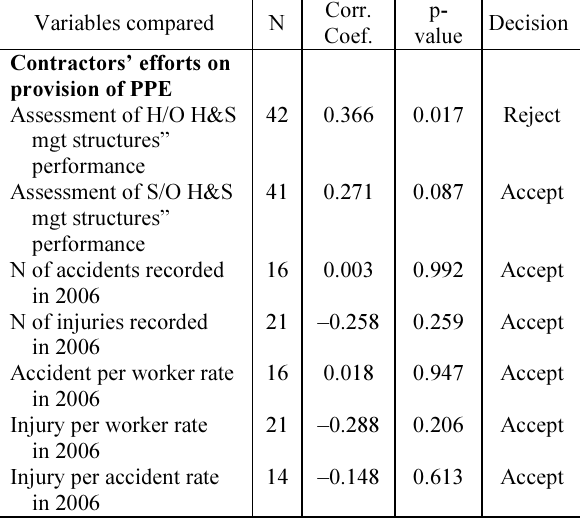
Table 6. Results of Spearman correlation between contractors’